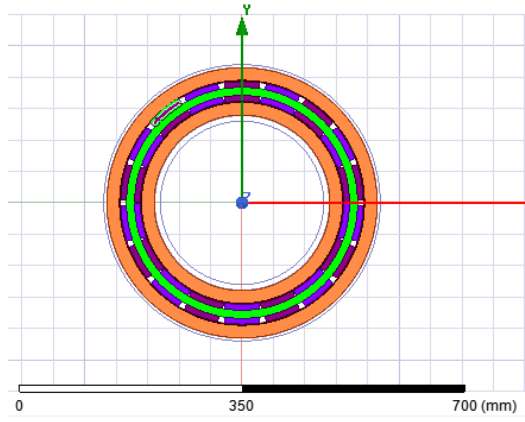
Figure 7. Two-dimensional model of the permanent magnet braking device.